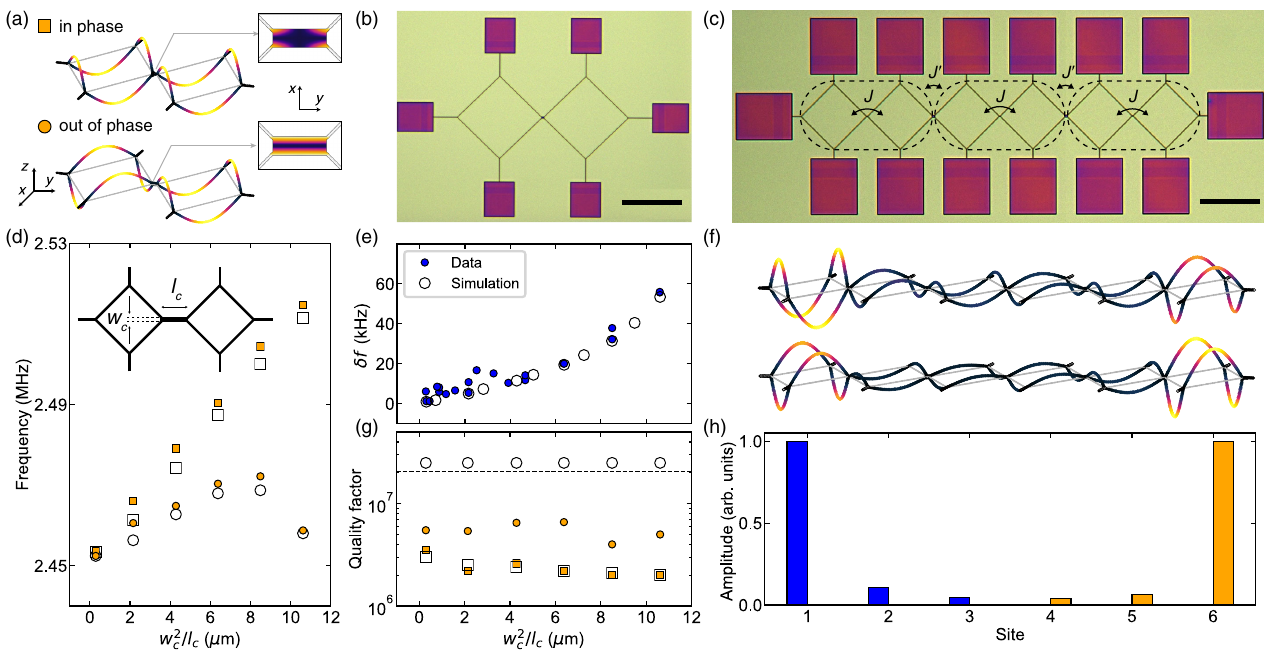
FIG. 6. Phononic dimers and arrays of polygon resonators. (a) FEM simulations of the in-phase and out-of-phase modes of a phononic dimer. The insets show the deformation of the coupler segment for the two cases. (b),(c) Optical micrographs of a fabricated dimer and a chain, both composed of square-shaped resonators with side lengths of 100 μ m. The scale bars correspond to 100 μ m. (d) The frequencies of the in-phase (square) and out-of-phase (circle markers) modes from data (filled markers) and FEM simulation (empty markers) for different coupling parameters. The inset indicates the coupling parameters of a phononic dimer. (e) Frequency splitting of the in-phase and the out-of-phase modes from data (filled markers) and FEM simulation (empty markers) for different coupling parameters. (f) FEM simulation of the edge mode profiles of a phononic array made of six square-shaped resonators. The slight asymmetry is due to the disorder in the mesh of the simulation. (g) Q of the hybridized modes from data (filled markers) and FEM simulation (empty markers) for different coupling parameters. The dashed line corresponds to quality factor of a single square-shaped resonator. (h) rms values of the Brownian motion of each site measured for the two split modes, showing localization of the mode at the edges of the